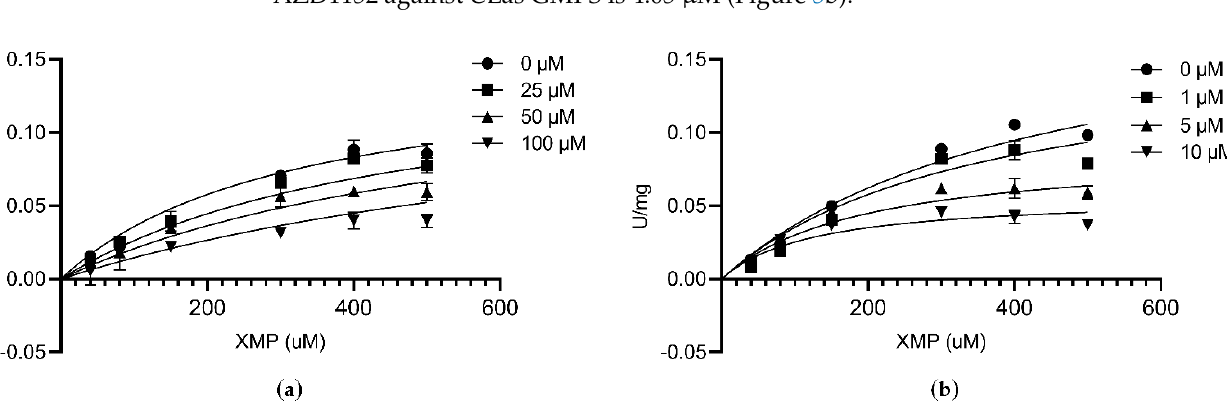
Figure 5. Inhibition kinetics at different concentrations of compounds by varying the XMP concentrations at a fixed ATP and glutamine concentration. ( a ) Folic acid; ( b ) AZD1152.